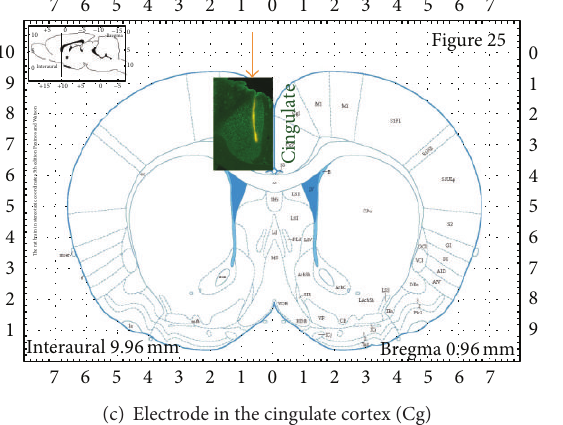
Figure 1: The recording electrodes in the brain. The drawings of the brain coronal section are from the rat brain atlas [72] and the inserts are photomicrographs of the brain showing DiI labeling of the recording electrodes (pointed by the arrows) in the Str and LA (a), the HC (b), and the Cg